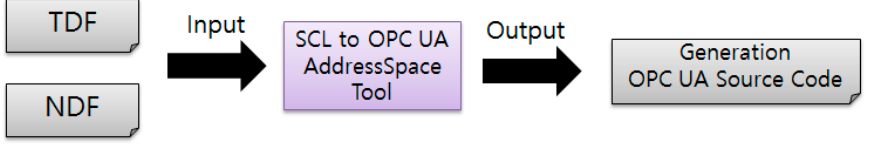
Figure 11. Step 2: Generation of OPC UA source code.